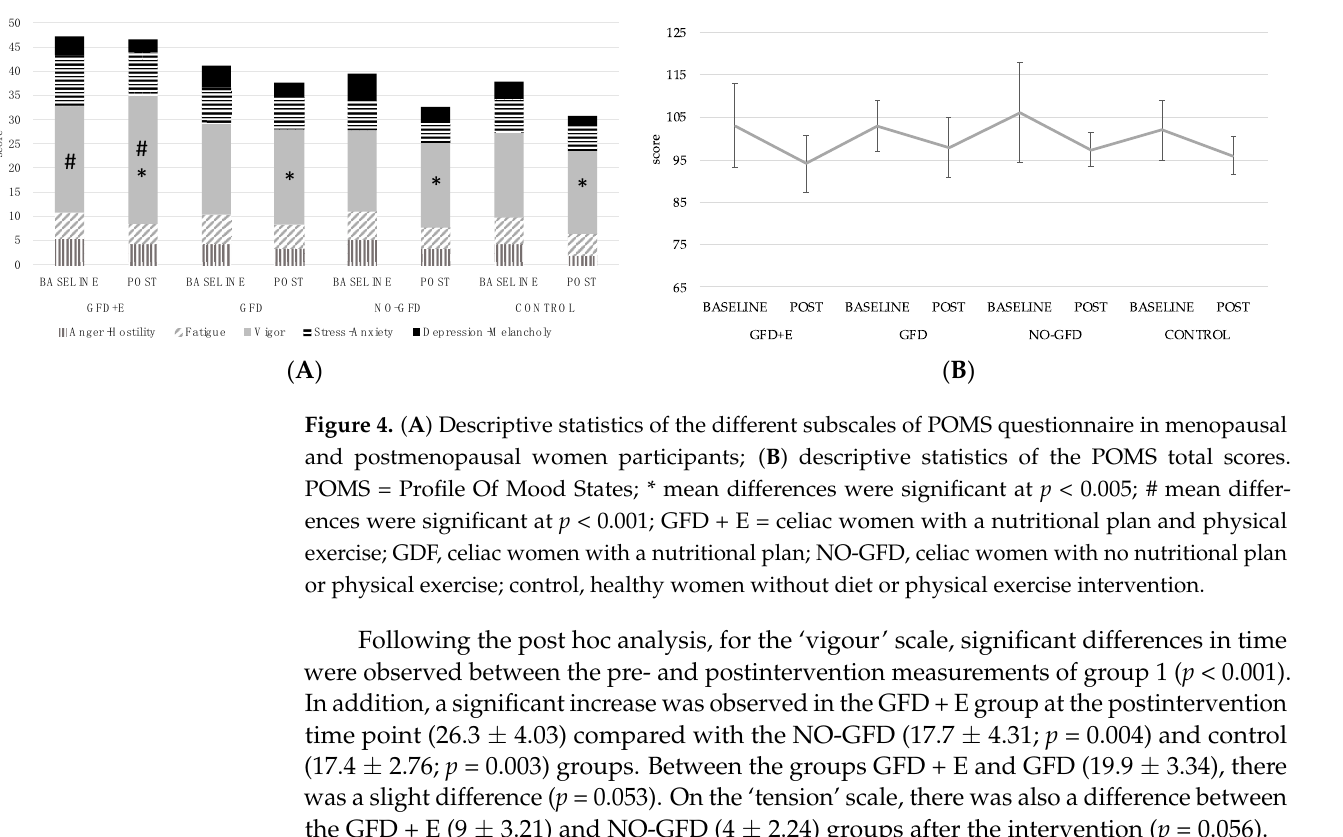
Table 1 . Descriptive data on bone quality.